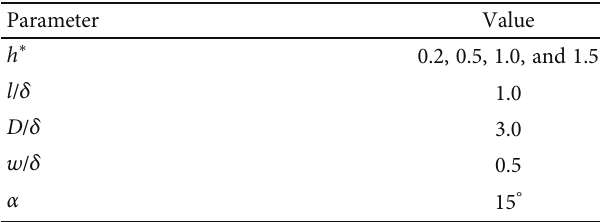
Table 1: Geometrical parameters for ramp-type VGs.